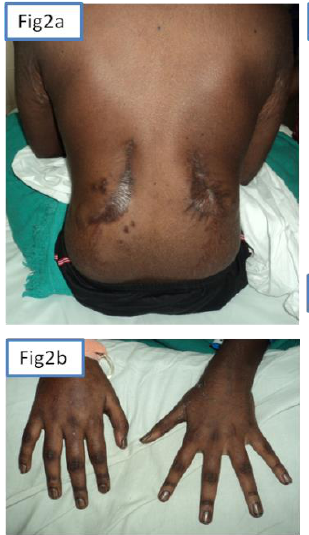
Figure 2a: Hyperpigmentation of the scars over the back and Fig2b: Hyperpigmentation of knuckles of